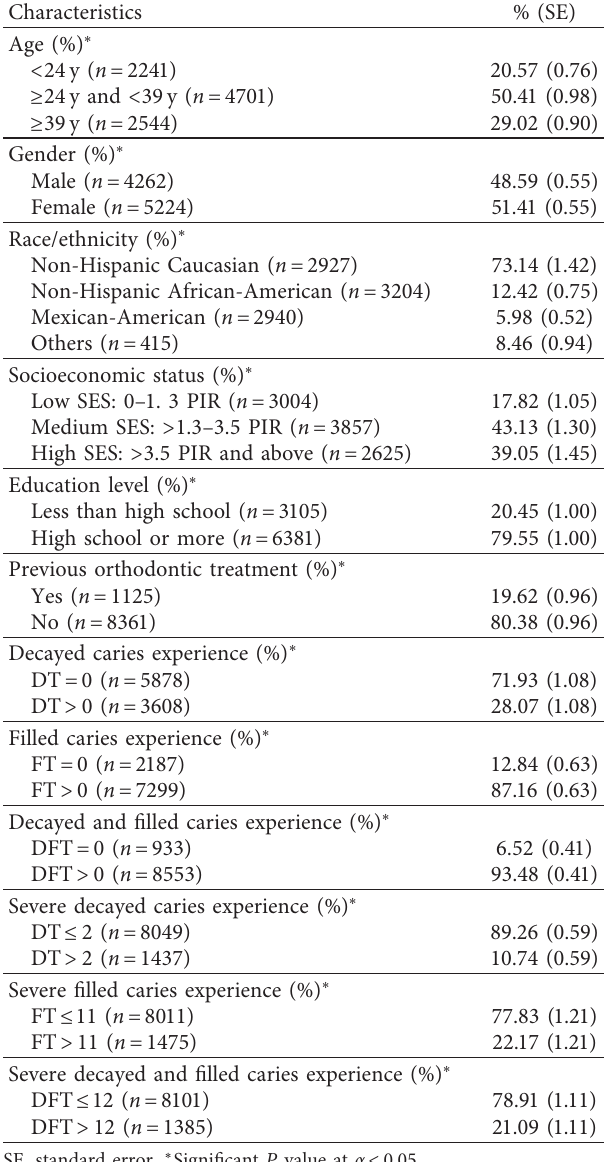
Table 1: Characteristics of the study participants ( n � 9486).